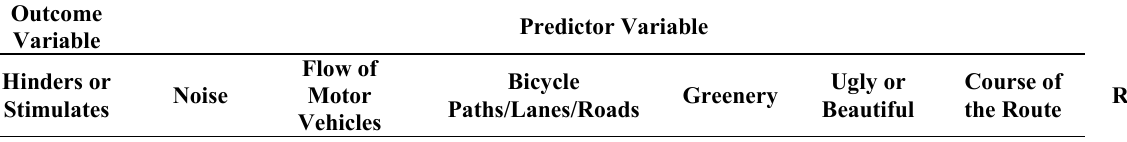
Table 6. Sensitivity analyses of Model 1 (n = 1087–1091).